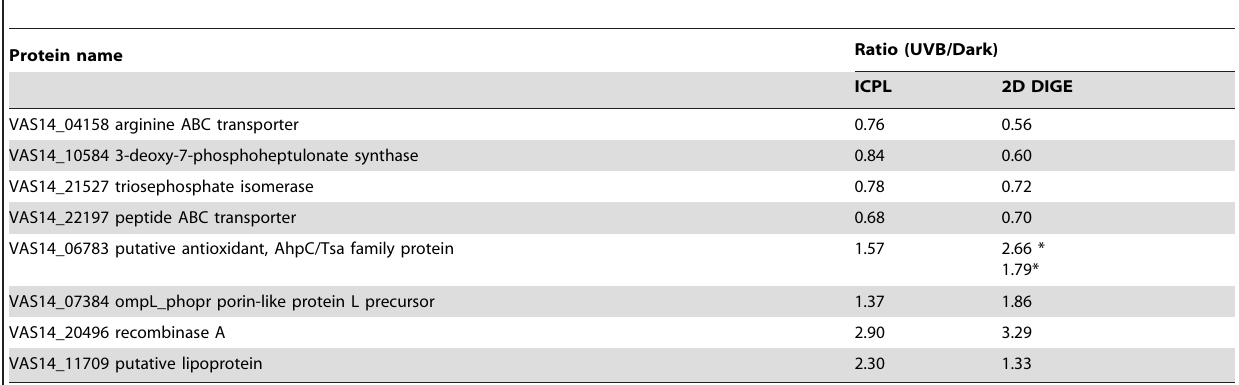
Table 3. UVB protein biomarkers of P. angustum quantified by both ICPL and 2D-DIGE.